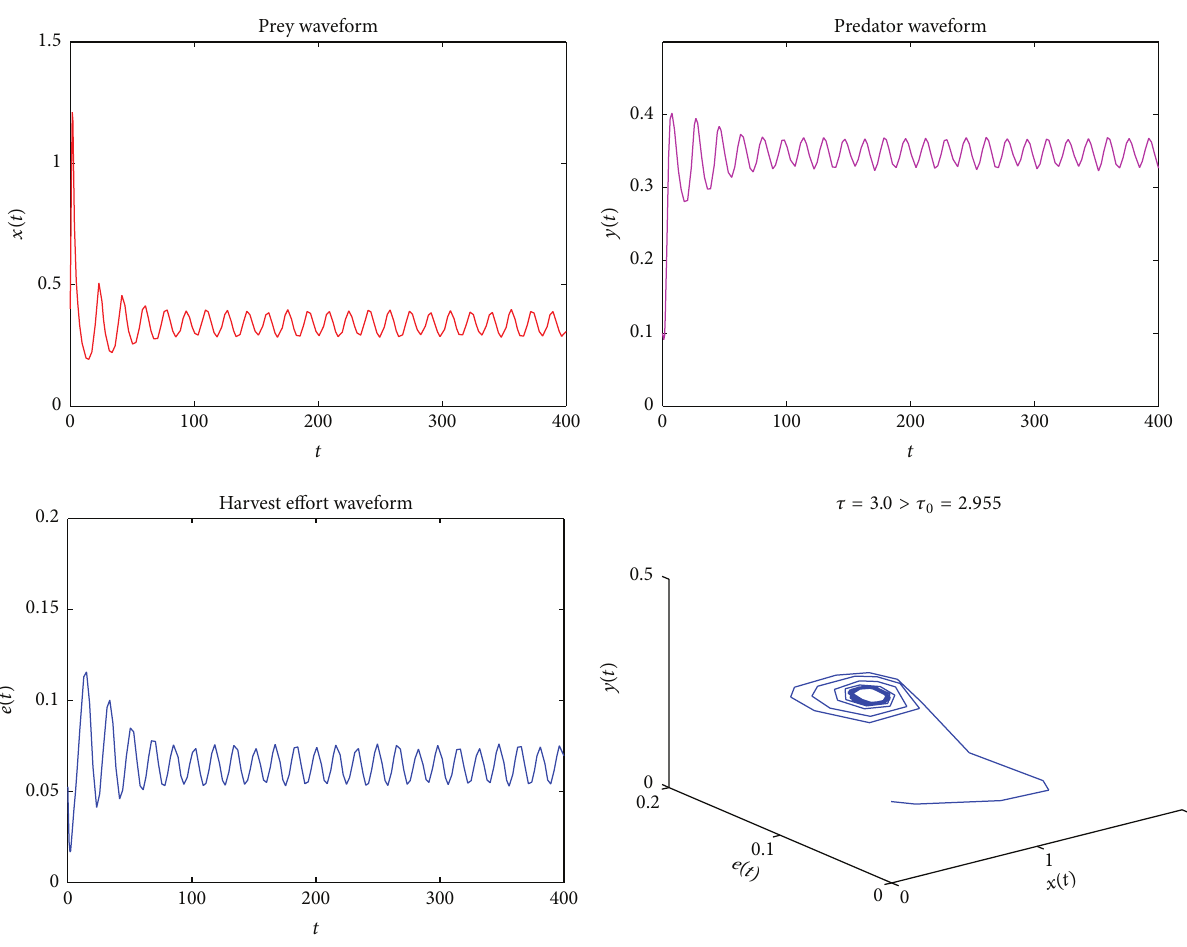
Figure 5: Hopf bifurcation occurs at the positive equilibrium when 𝜏 = 2.960 > 𝜏 0 = 2.955 .